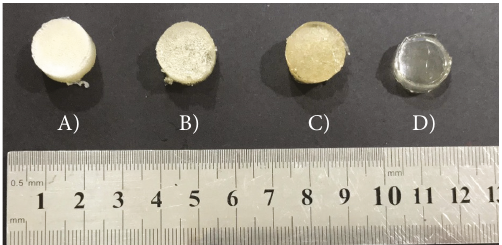
Figure 2: Hydrogels of gelatin and pectin, with di ff erent oxidation levels, obtained after 24 h of cross-linking. The samples shown are (A) H.6.20 (6% HOP and 20% of gelatin), (B) L.6.20 (6% LOP and 20% of gelatin), (C) N.6.20 (6% NOP and 20% of gelatin), and (D) 0.20 solely gelatin (20%